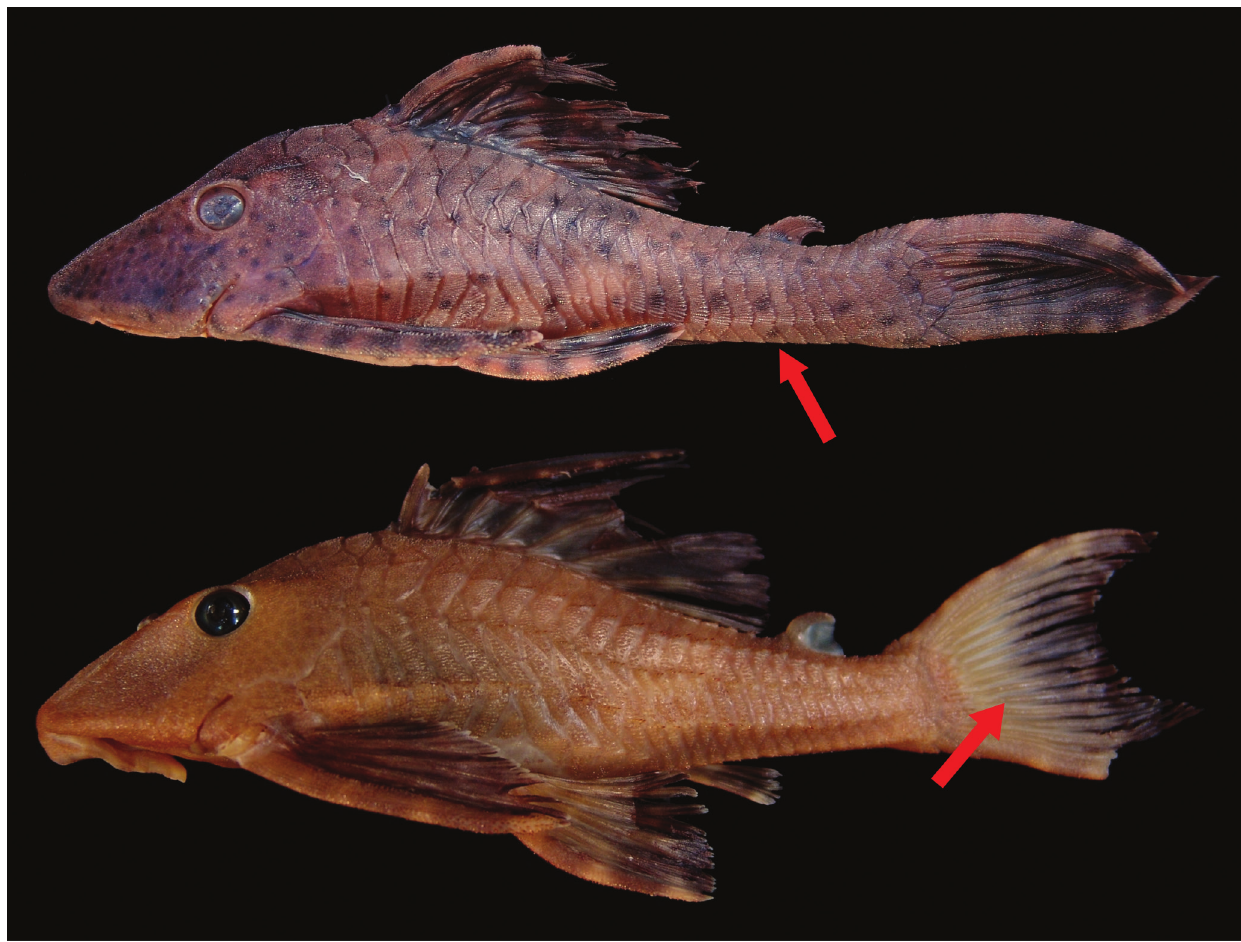
Fig. 5. Hypostomus ericae NUP 6436, 155.6 mm SL; Brazil, Mato Grosso State, Barra do Garça, rio Araguaia basin, córrego Fundo (a); Hypostomus ericius MUSM 27553, 118.9 mm SL: Peru, Ucayali Department, río Breu basin, río Yrua (b). Red arrows highlight the spotted ventrolateral region of caudal peduncle in H. ericae and the caudal fin dark blurred distally in H. ericius .